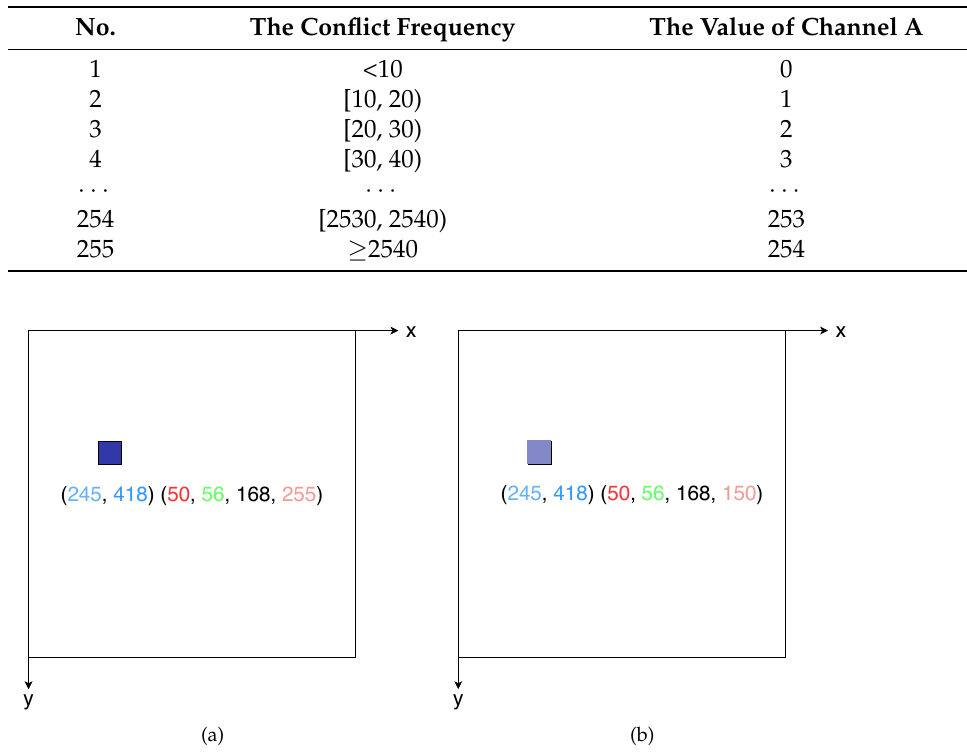
Table 2. The mapping table between conflict frequency and channel A.